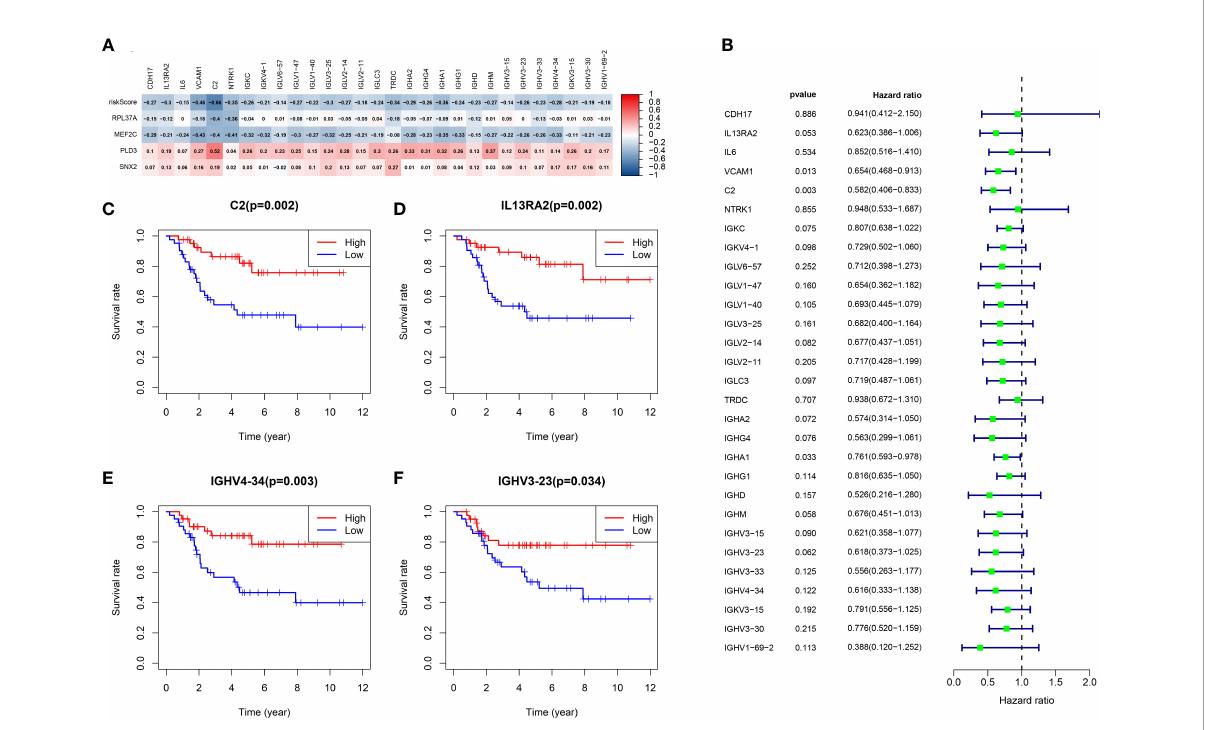
FIGURE 10 Analysis of B-cell activation pathway genes. (A) Heat map of risk score and correlation analysis offour prognostic genes with 29 B-cell activation pathway genes. (B) Univariate cox analysis of 29 genes and overall survival. (C-F) Survival curves offour genes associated with B-cell activation.